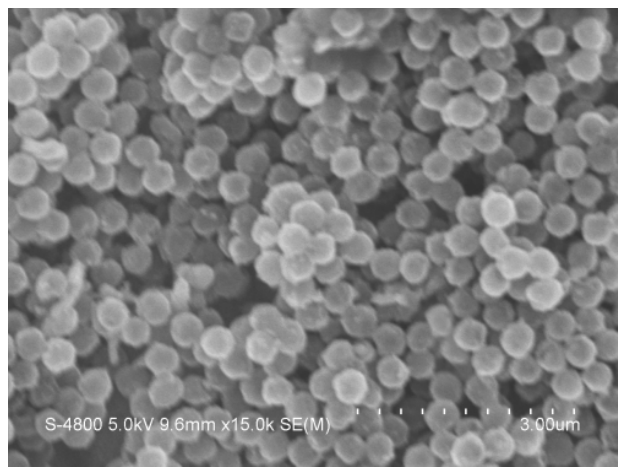
Figure 1. SEM images of carbon